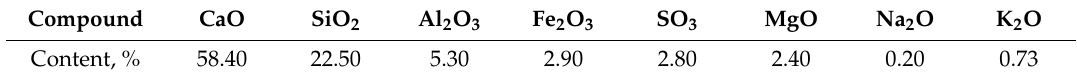
Table 1. Cement composition guaranteed by producer (CEM II / A-S 52.5 N).